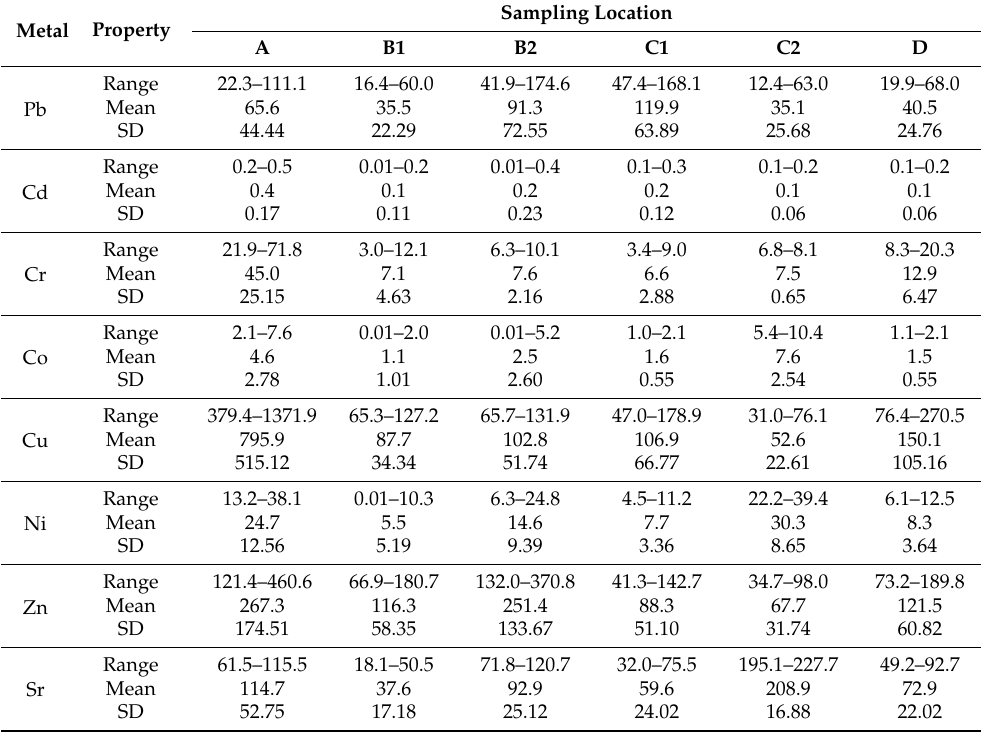
Table 1. Metals contamination (mg · kg − 1 d.w.) depending on the sampling location: A (inter-railway, depth 20 cm), B1 (5 m from the main track, depth 0–5 cm), B2 (5 m from the main track, depth 20 cm), C1 (embankment, 10 m from the main track, depth 0–5 cm), C2 (embankment, 10 m from the main track, depth 20 cm), D (side track, depth 20